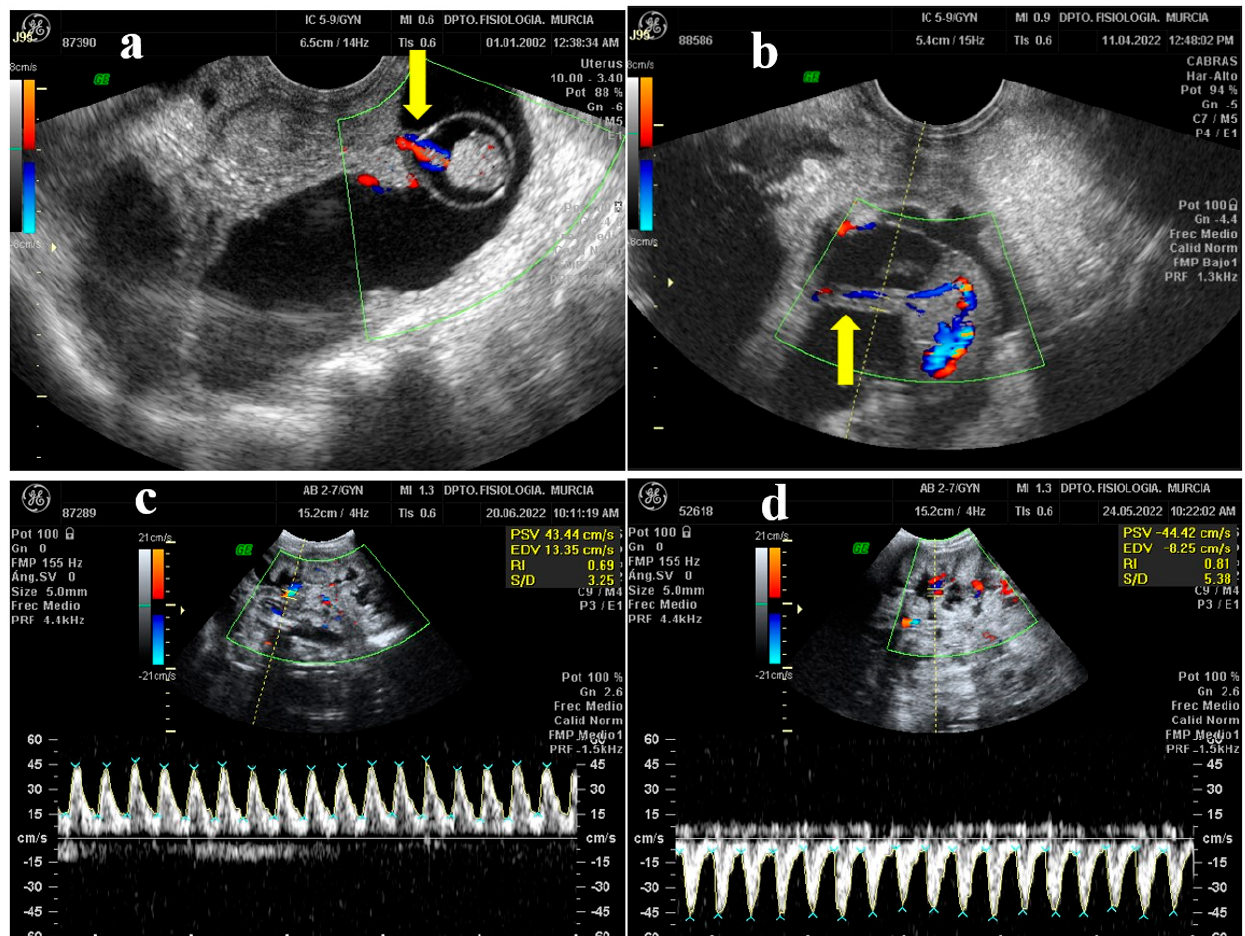
Figure 2. Ultrasound images of the study of the umbilical cord of M-G breed goat fetuses. ( a ) Early identification of the umbilical cord (arrow) of the embryo (32 dpm). ( b ) Color Doppler ultrasound identification of the umbilical cord (arrow), where red colors reflect blood approaching the transducer and blue colors reflect blood moving away. ( c ) Umbilical arterial flow waves by color Doppler and spectral Doppler, where blood flow is directed towards the transducer and shown with positive values above baseline. ( d ) In this image, the flow is moving away from the transducer and is represented by negative values below the baseline. PSV: Peak Systolic Velocity. EDV: End Diastolic Velocity. RI: Resistance Index. S/D: Systolic/Diastolic Ratio